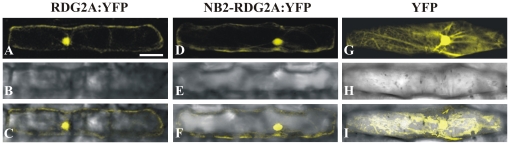
Sub-cellular localization of RDG2A and NB2-RDG2A proteins.Barley cv. Golden Promise epidermal cells were transiently transformed with constructs expressing RDG2A:YFP and NB2-RDG2A:YFP fusion proteins (A and D respectively), driven by the maize polyubiquitin gene promoter. A construct expressing YFP alone with the same promoter was used as control (G). Fluorescence signals were visualized using confocal laser scanning microscopy (A, D and G). Bright field images (B, E and H) and merged images (C, F and I) are shown. Scale bar represent 50 µm.